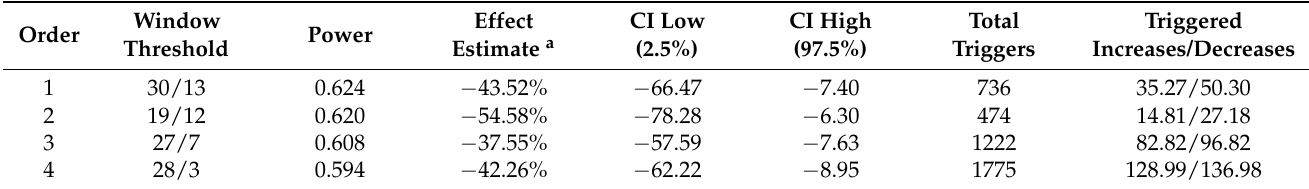
Table 4. Order of static algorithm settings with respect to power